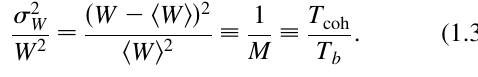
where T is the duration of an electron bunch having b uniform average density. For z fixed, one can think of dividing the pulse into M statistically independent time intervals of width T . The energy fluctuation within a coh single coherent region is 100%, but the fluctuation (cid:10) of the energy in the entire pulse is reduced and given by